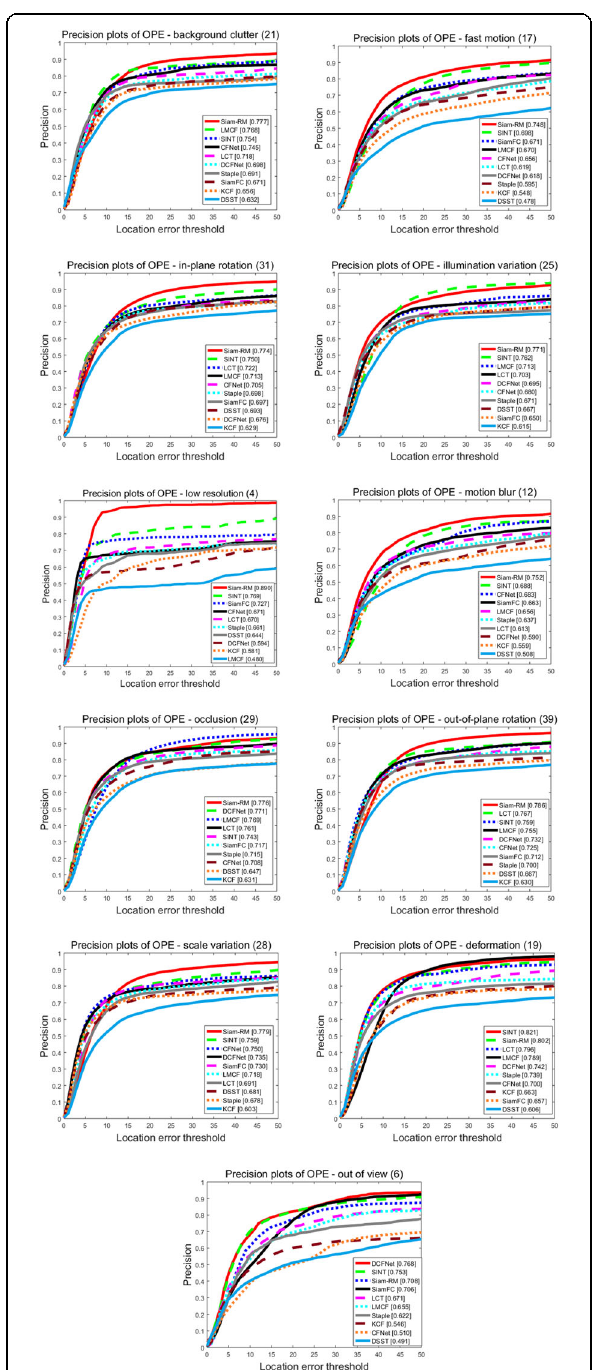
Fig. 7 Precision plots of OPE in 11 attributes. The OTB sequences can be divided into 11 attributes, including illumination variation (IV), out-of-plane rotation (OPR), scale variation (SV), occlusion (OCC), deformation (DEF), motion blur (MB), fast motion (FM), in-plane rotation (IPR), out-of-view (OV), background cluttered (BC), and low resolution (LR). The precision plots of each attribute represent